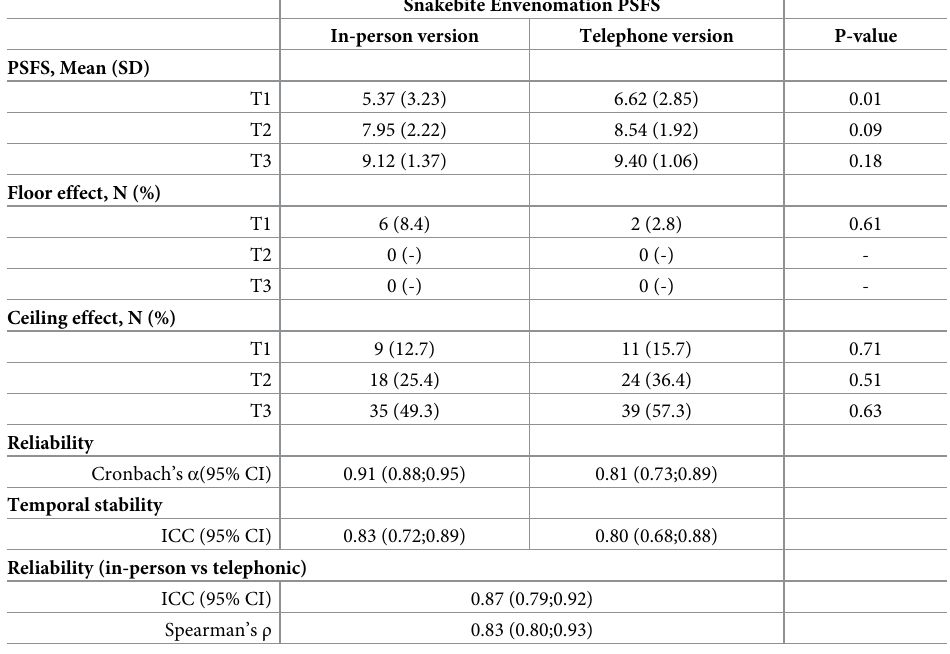
Table 1. Psychometric properties for content and construct